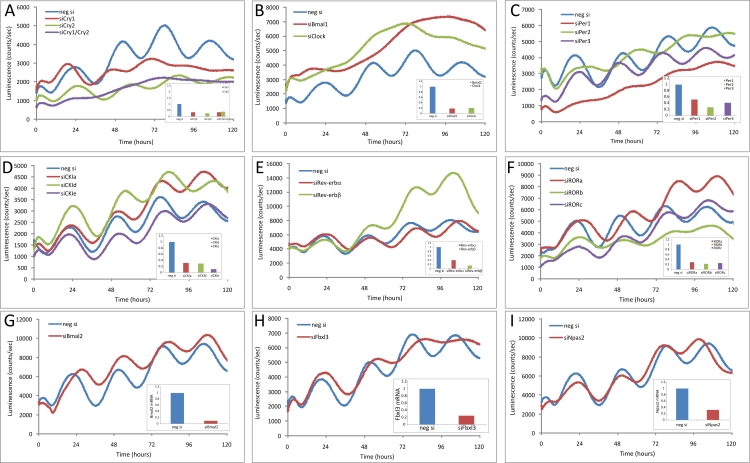
Functional Effects on Oscillations Following Knockdown of Circadian Clock Components in U-2 OS CellsU-2 OS cells were transfected with pools of four to five siRNAs for each gene, and oscillations in Bmal1-luciferase were measured for 5 d following synchronization with dexamethasone. Knockdown of each component was validated by quantitative RT-PCR from RNA isolated from a replicate sample. The relative amount of expression of each gene compared to the negative siRNA control sample is shown (insets). Results are representative of three independent biological replicates.